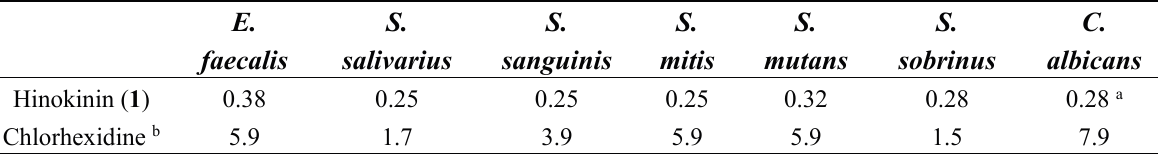
Table 5. Minimum inhibitory concentrations (MIC; mM) of hinokinin against oral pathogens.